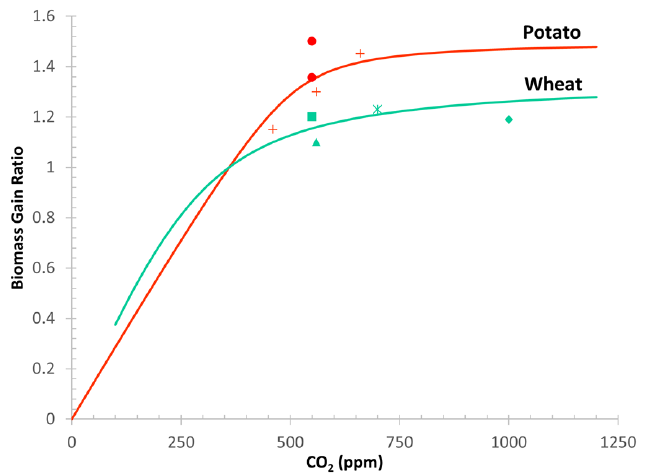
Figure 2. Biomass gain ratio as a function of atmospheric CO 2 concentration relative to CO 2 of 360 ppm to potato and wheat. FACE data for potato are from Miglietta et al. [43] and Bindi et al. [44] while FACE data for wheat are from Long et al. [38]; Kimball et al., [40]; Ziskas and Bunce [45] and Reuveni and Bugbee [46].